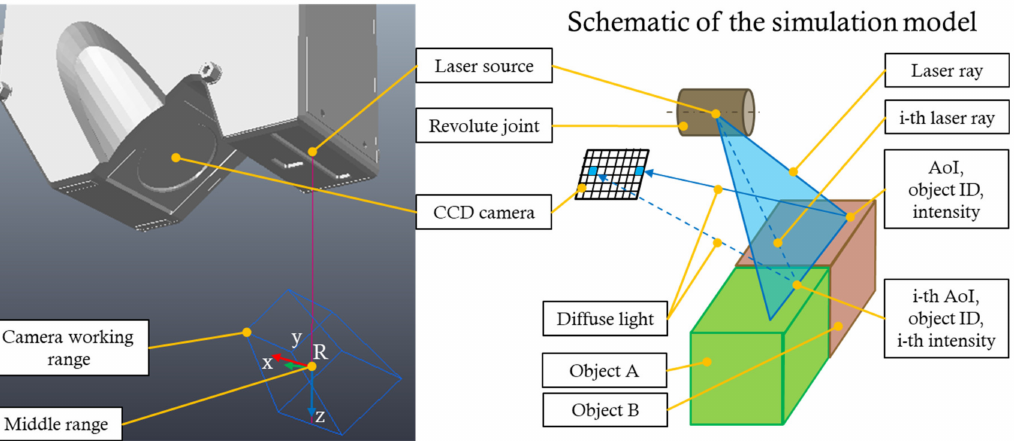
Figure 1. Simulation model of the LLT sensor LJ-X8080. Middle range is denoted as R and represents the middle range of the sensor—the coordinates at this point are X, Z (0, 0).